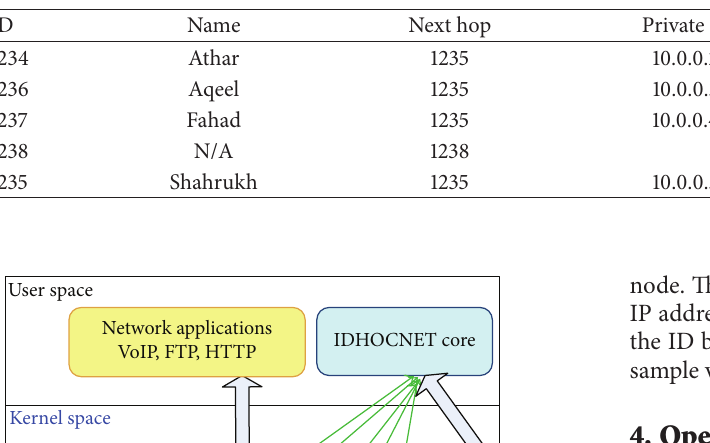
Table 2: User accessible information of network peers.